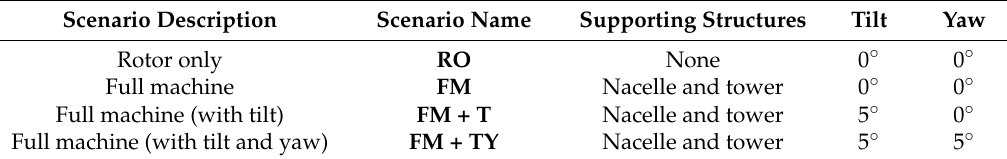
Table 1. Summary of the simulation scenarios analyzed.